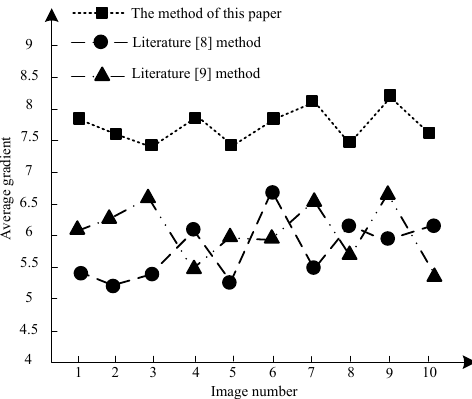
Figure 4. Average gradient comparison